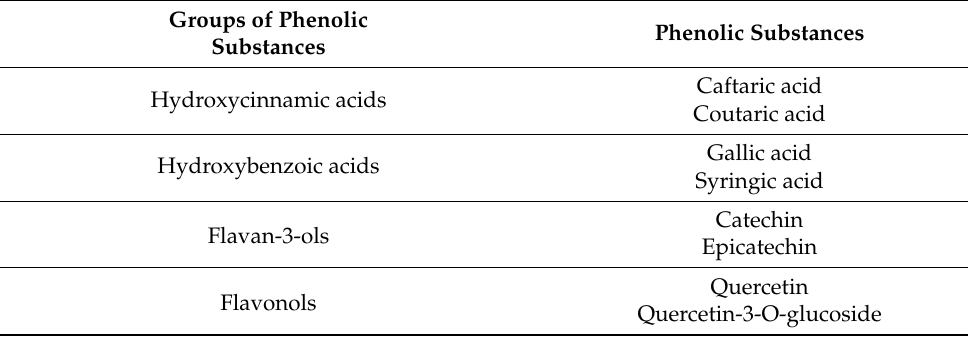
Figure 6. Process flow of Neural Network Training and Testing. Table 5. Indicators of the mass concentration of phenolic substances and antioxidant